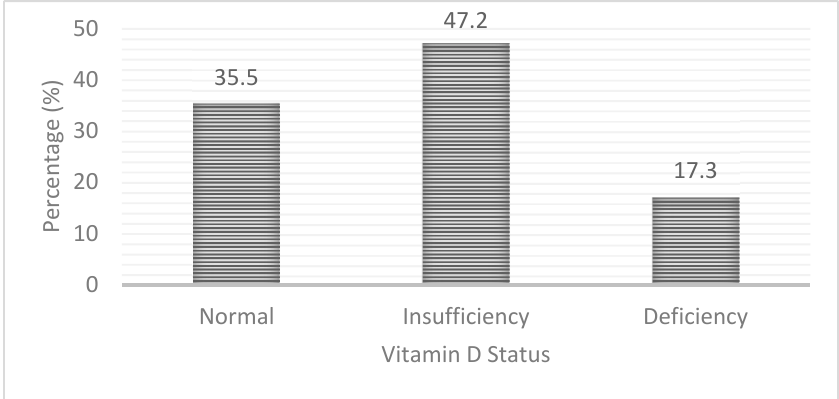
Figure 1. Prevalence of vitamin D insufficiency and deficiency among pregnant rural women in Bangladesh.